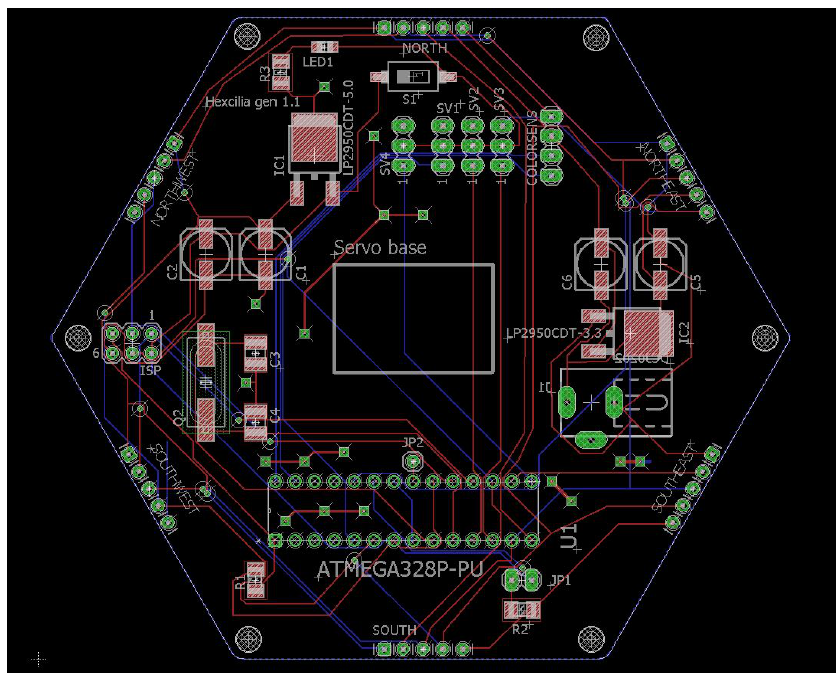
Figure 5. Hexagonal cilia board layout for the Printed Circuit Board created using EagleCAD design software (Autodesk, San Rafael, CA,